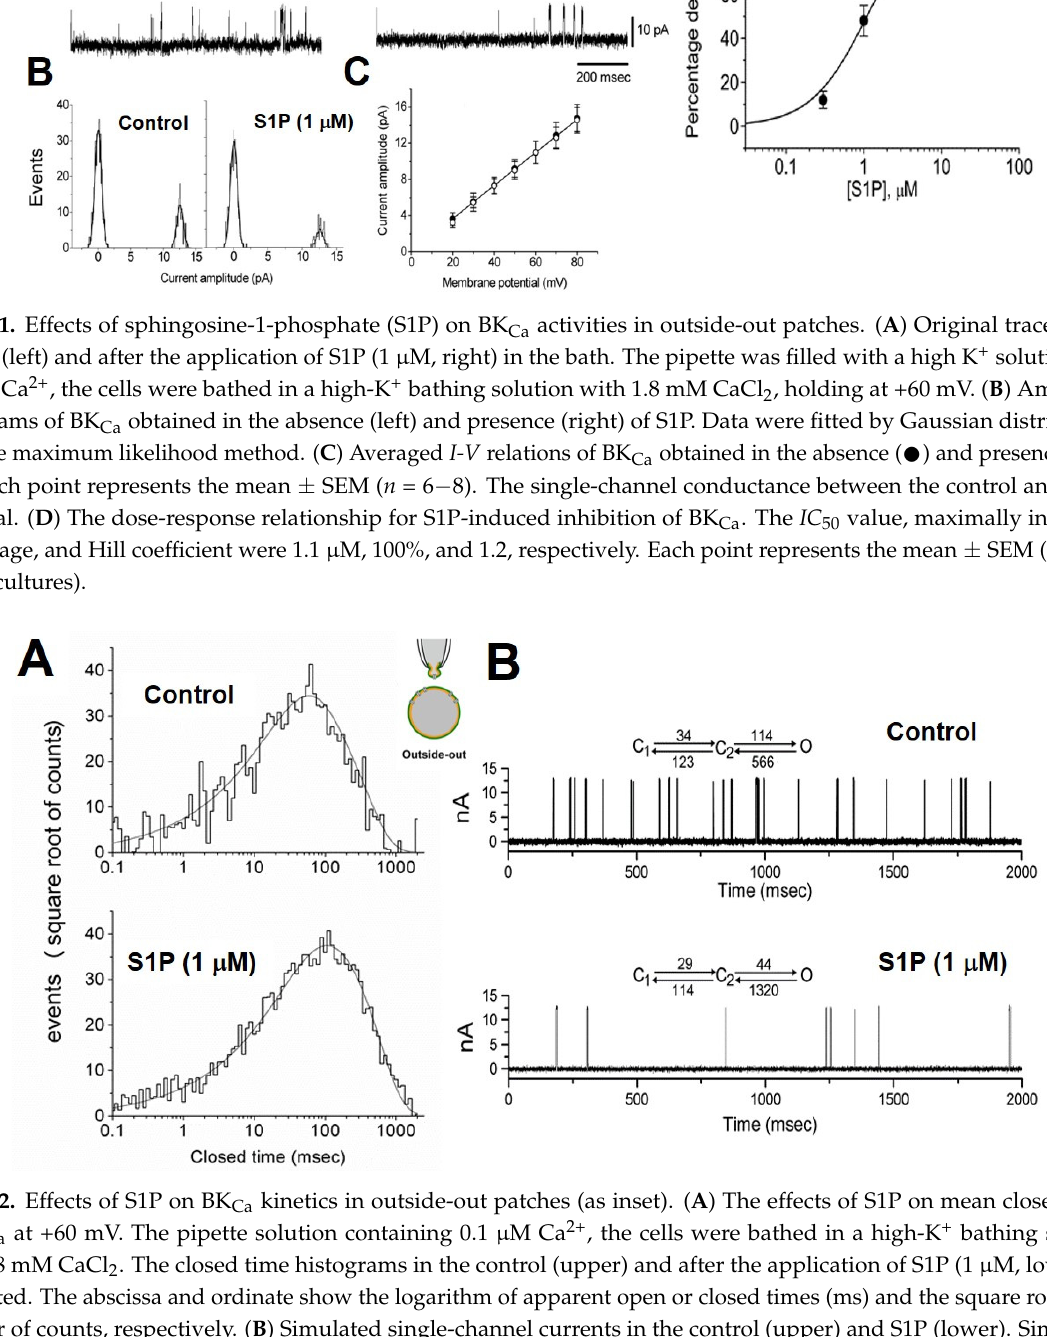
Figure 2. Effects of S1P on BK Ca kinetics in outside-out patches (as inset). ( A ) The effects of S1P on mean closed times of BK Ca at +60 mV. The pipette solution containing 0.1 µ M Ca 2+ , the cells were bathed in a high-K + bathing solution with 1.8 mM CaCl 2 . The closed time histograms in the control (upper) and after the application of S1P (1 µ M, lower) are illustrated. The abscissa and ordinate show the logarithm of apparent open or closed times (ms) and the square root of the number of counts, respectively. ( B ) Simulated single-channel currents in the control (upper) and S1P (lower). Simulation models used to analyze the observed data measured at +60 mV are shown in the upper part of each simulated current. Each horizontal arrow pointing to the left represents the binding of S1P or closing of a channel, and each arrow to the right represents the dissociation of S1P or opening of a channel. The units are µM/ms or /ms. O: Open state; C 1 and C 2 , two closed states.